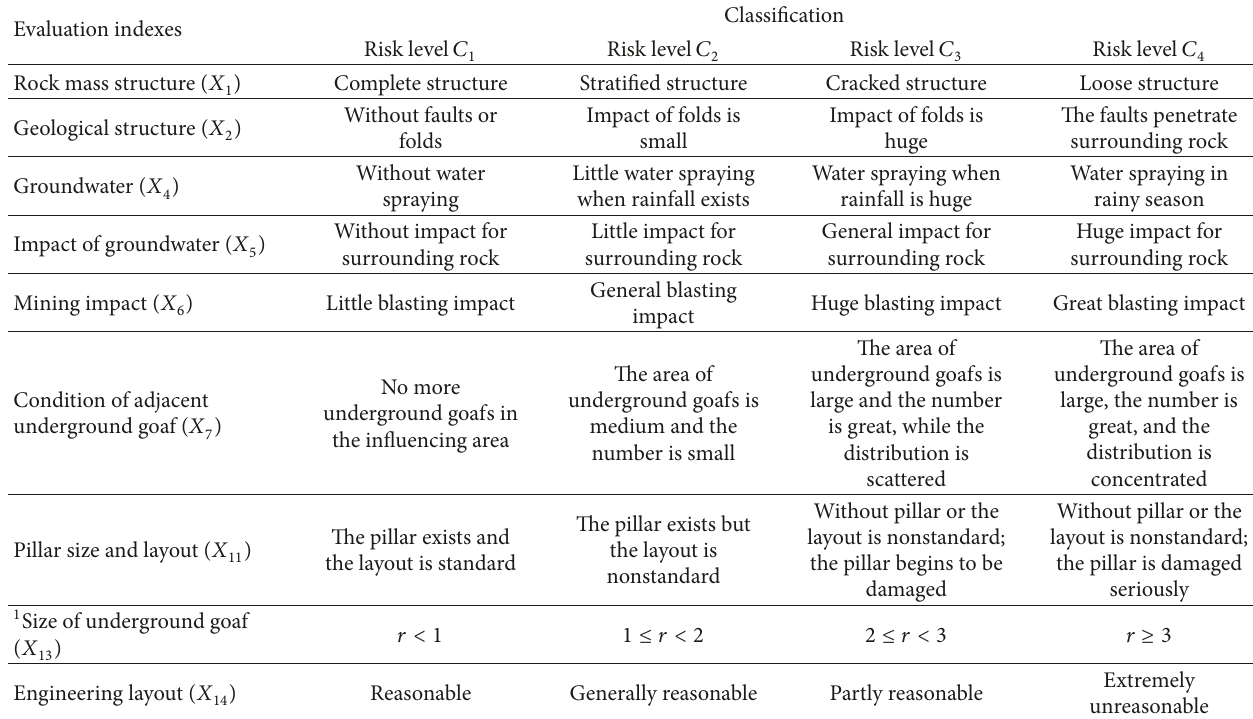
Table 1: Classification criteria for evaluation of risk levels with qualitative